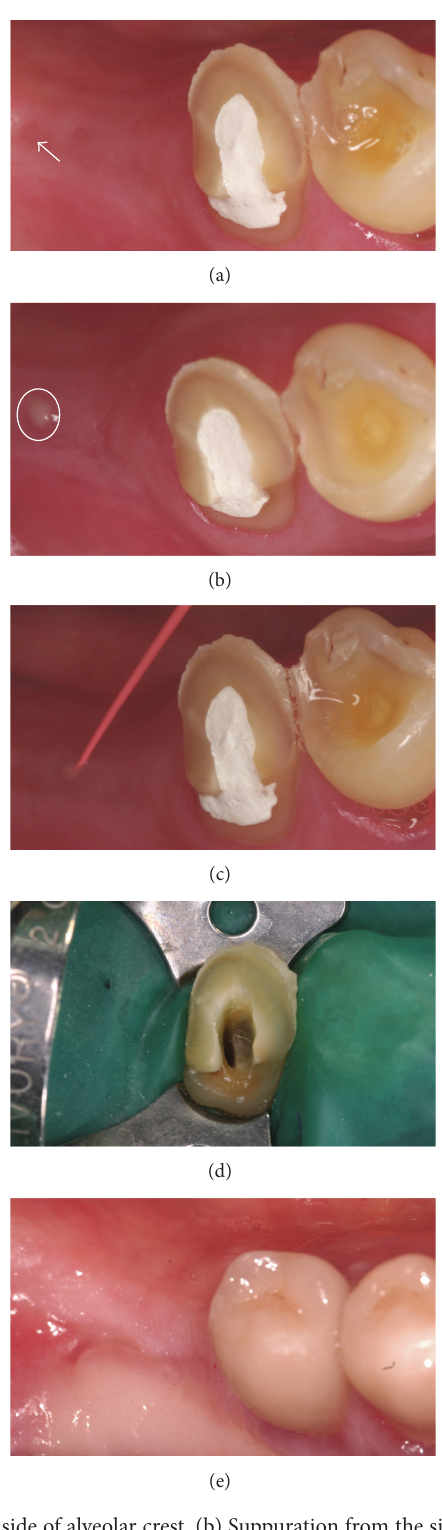
Figure 1: (a) Drained sinus tract on the top side of alveolar crest. (b) Suppuration from the sinus tract. (c) Tracking of the sinus tract with gutta-percha point. (d) Access cavity and rubber dam. (e) Clinical situation after complete healing (18 months after the